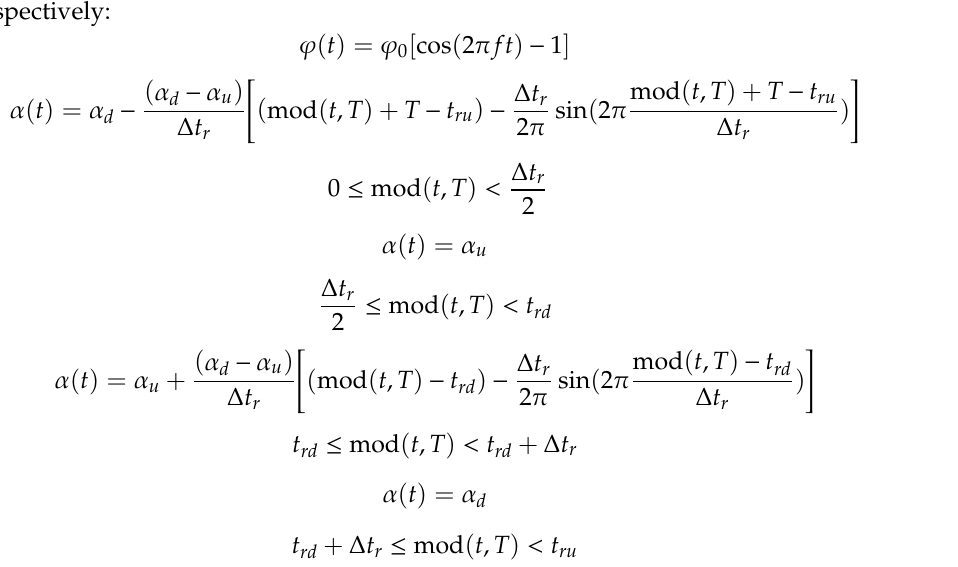
Figure 3. Sketch of the flapping motion of the wing.